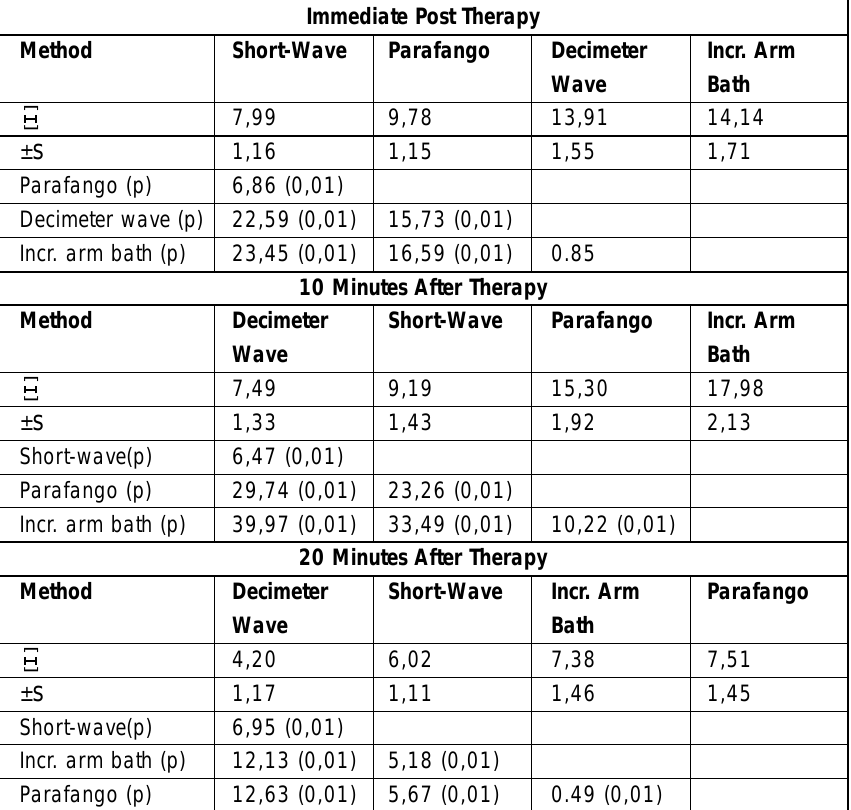
Table 2: Mean value comparisons (Newman-Keuls-test) of the post therapeutic reaction of circulation on the application side within the healthy